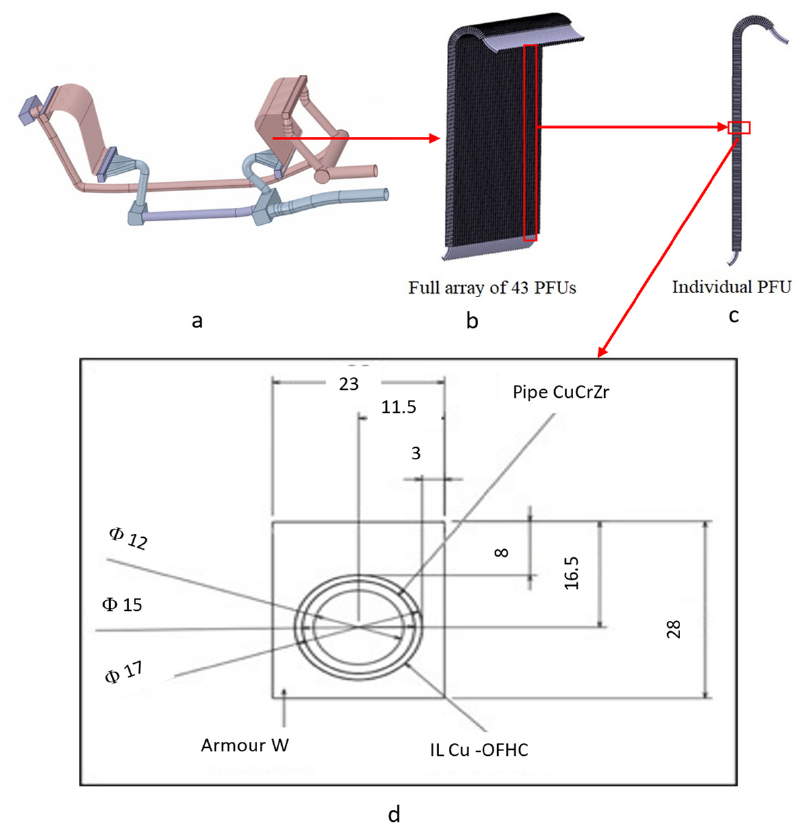
Figure 3. Divertor targets ( a ), array of PFU detail ( b ), individual PFU ( c ), overview of PFU tile and pipe dimensions (reported in mm) ( d ).